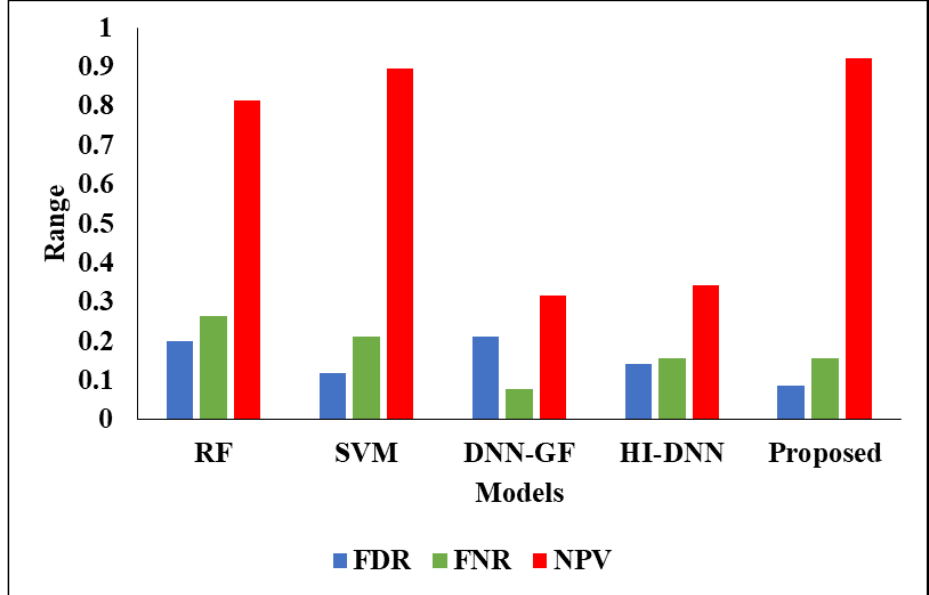
Figure 7. Analysis of the proposed model in terms of various metrics.